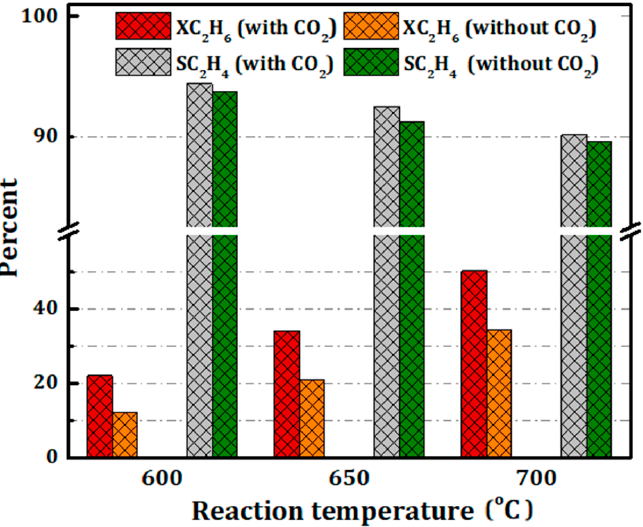
Figure 9. Effects of CO 2 addition on the conversion of ethane and selectivity of ethylene for the Cr(8)/MOS catalyst at different temperatures.